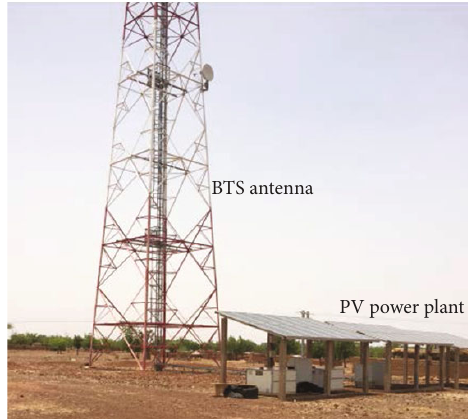
Figure 1: PV system in vicinity of the BTS antenna.